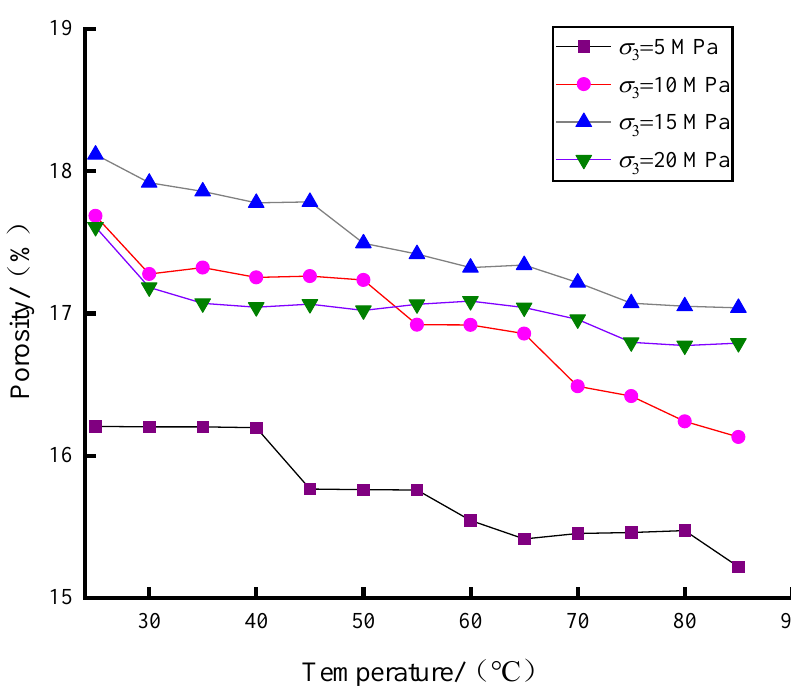
Figure 10. Calculated values of porosity at different temperatures.